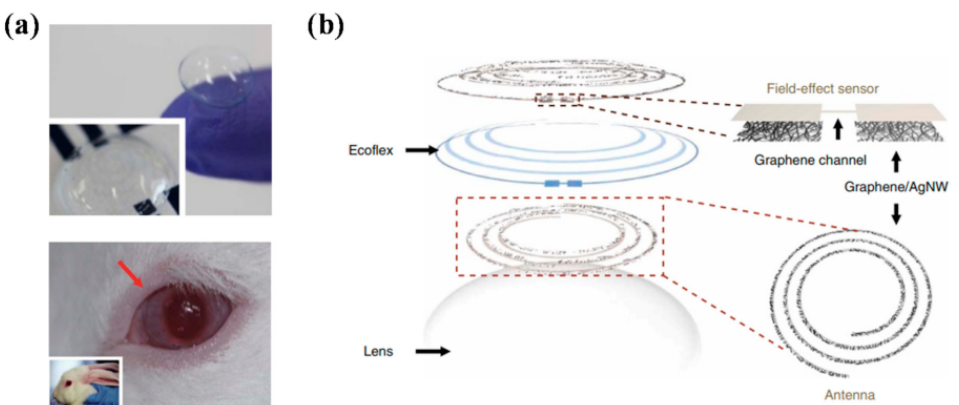
Figure 3. Wireless glucose and intraocular pressure sensor constructed on a contact lens. ( a ) Photographs of the transparent wireless contact lens biosensor (top) and the sensor applied to the rabbit’s eye (bottom); ( b ) configuration of the wireless contact lens biosensor [73]. Reproduced with permission from Kim, Nature Communications; published by Nature Publishing Group,